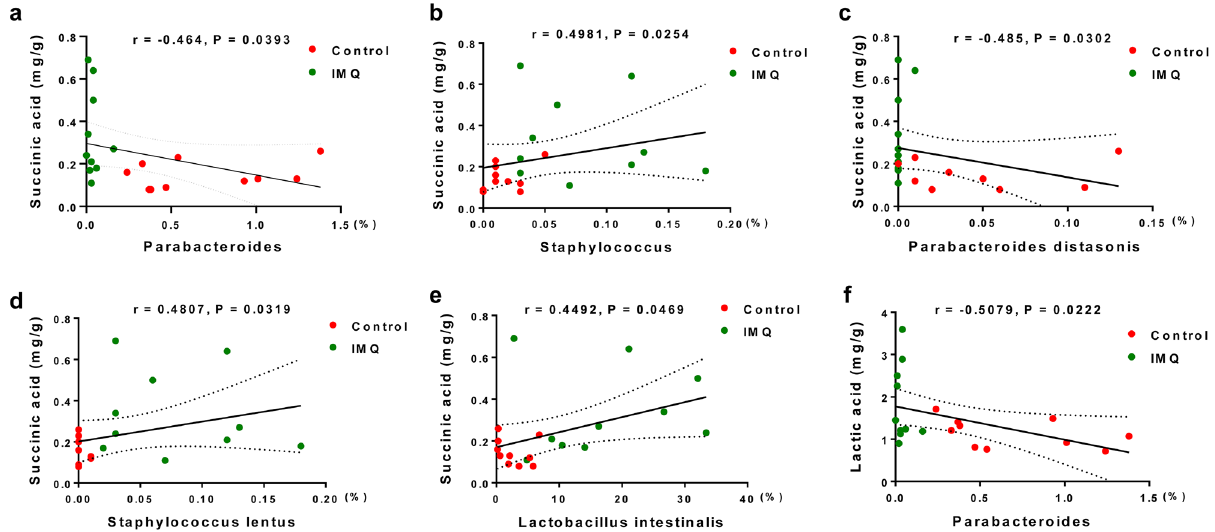
Figure 5. The correlations between bacterial relative abundance and SCFAs. ( a ) A significant negative correlation (r = − 0.464, P = 0.0393) between the relative abundance of the genus Parabacteroides and succinic acid was shown in the control group and IMQ group. ( b ) A significant positive correlation (r = 0.4981, P = 0.0254) between the relative abundance of the genus Staphylococcus and succinic acid was shown in